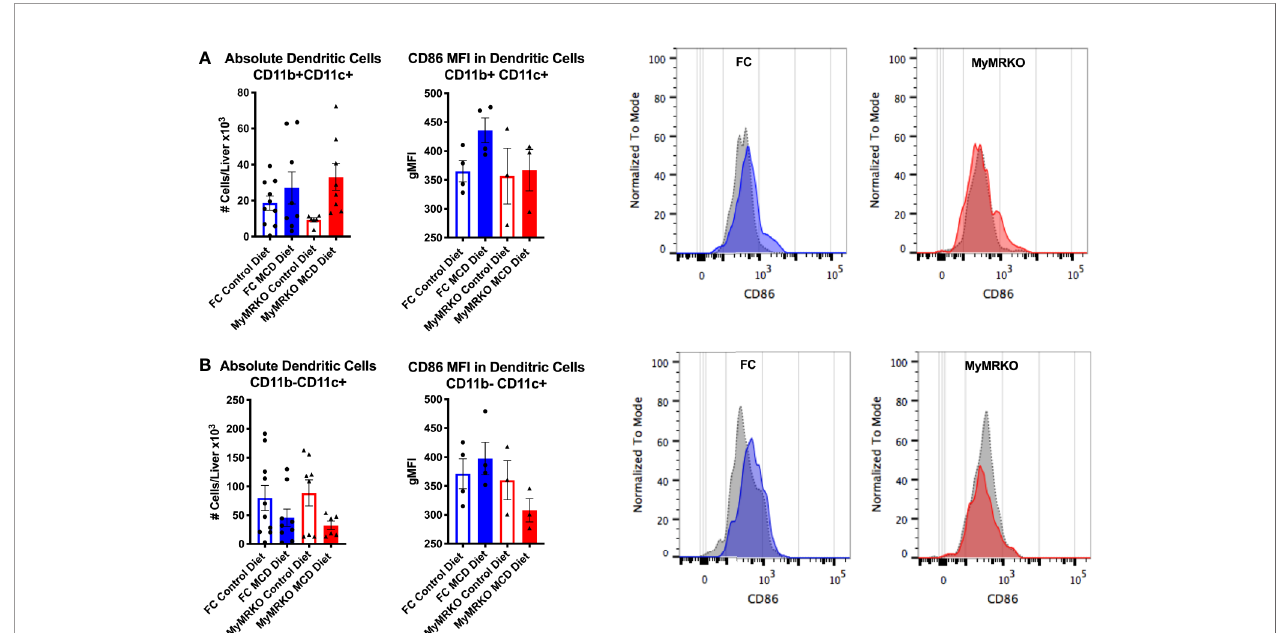
FIGURE 6 | Dendritic cell (DC) subsets in the liver of myleoid mineralocorticoide receptor knockout (MyMRKO) mice display a tendency to express lower CD86 independent of the cell number. Flow cytometry was used to measure the absolute number (left panel) and gMFI expression of Cd86 of two subsets of DCs: CD11b + CD11c + (A) and CD11b-CD11c + (B) . For each cellular subset a representative image of CD86 expression in fl oxed control (FC) and MyMRKO fed with chow diet (gray dotted histogram) or MCD diet (colored histogram) is shown. Statistical analysis was performed with one-way ANOVA comparing all treatments, with Tukey post-test. All fi gures display mean ± SEM. Statistical differences were considered signi fi cant according to *p <